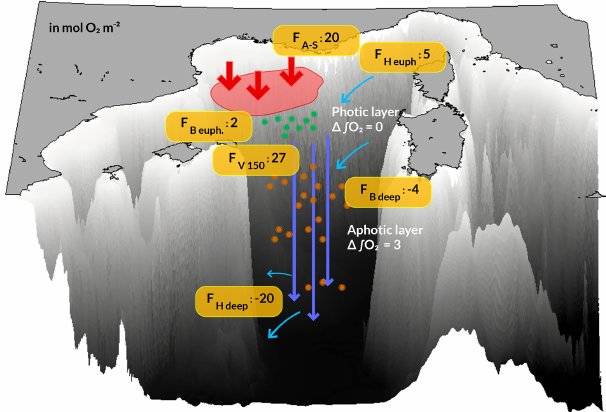
Figure 10. Schematic showing the terms of the annual oxygen budget (mol O 2 m − 2 ) for the north-western Mediterranean deep- convection area over the period from September 2012 to September 2013. F A–S : air-to-sea flux; F H : net horizontal transport; F v 150 : net downward transport at the base of the euphotic layer (150m); F B : net biogeochemical production; (cid:49) (cid:82) O 2 : variation in oxygen inven- tory. Positive fluxes are inputs for the deep-convection zone. The terms of the budget are estimated for the upper euphotic layer (sur- face to 150m) and the deeper aphotic layers (150m to